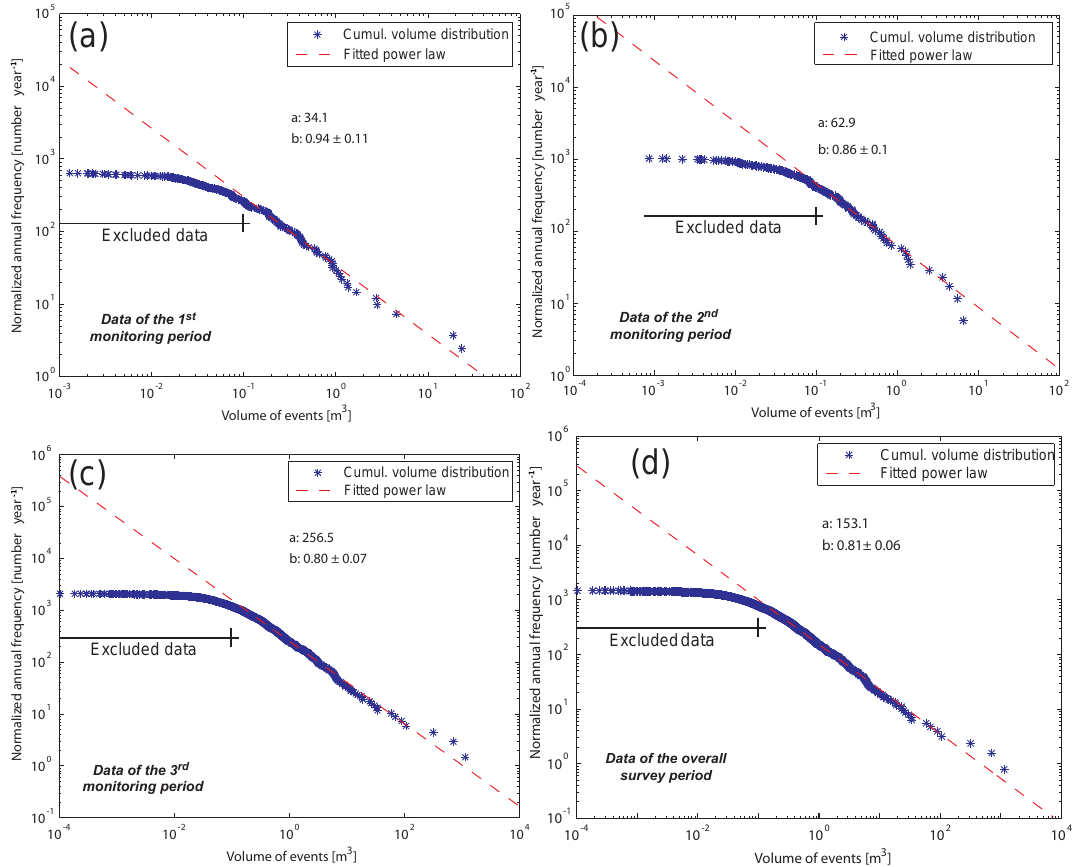
Figure 10. Cumulative volume distribution of the rockfall observed during the first (a) , the second (b) , and the third monitoring period (c) and over the entire study time of 16 months (d) . For each dataset, the power law is fitted for volumes larger than 0.1m 3 . Below this threshold volume, the distribution exhibits a rollover that progressively reaches an almost constant frequency for the smallest detected volumes.